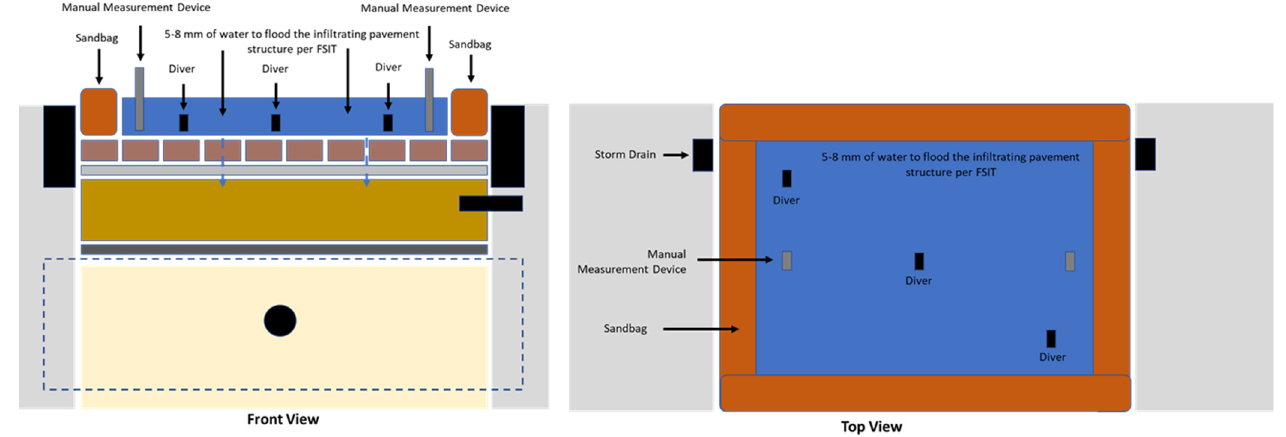
Figure 2. Typical setup of a full-scale infiltration test on infiltrating pavements (Adapted with permission from [28]).